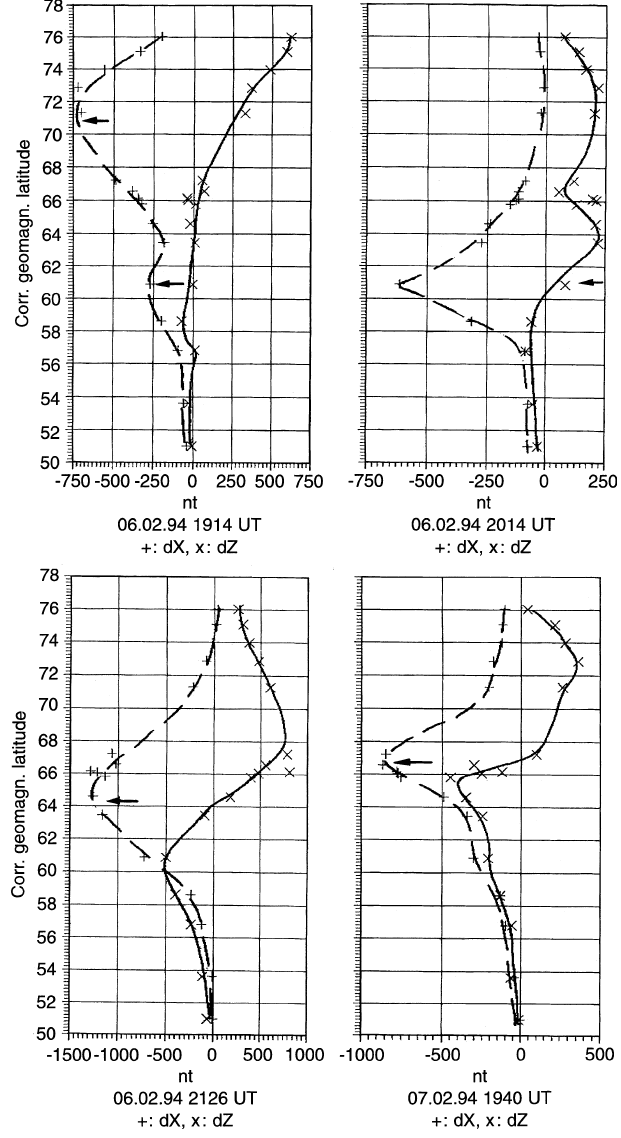
Fig. 4. The latitudinal cross sections through the westward electrojet on February 06, 1994 at 1914 UT and 2126 UT, February 07 at 1940 UT during substorms maxima, on February 06, 1994 at 2014 UT during quiet intervals between substorms. Arrows mark the latitudes of the westward